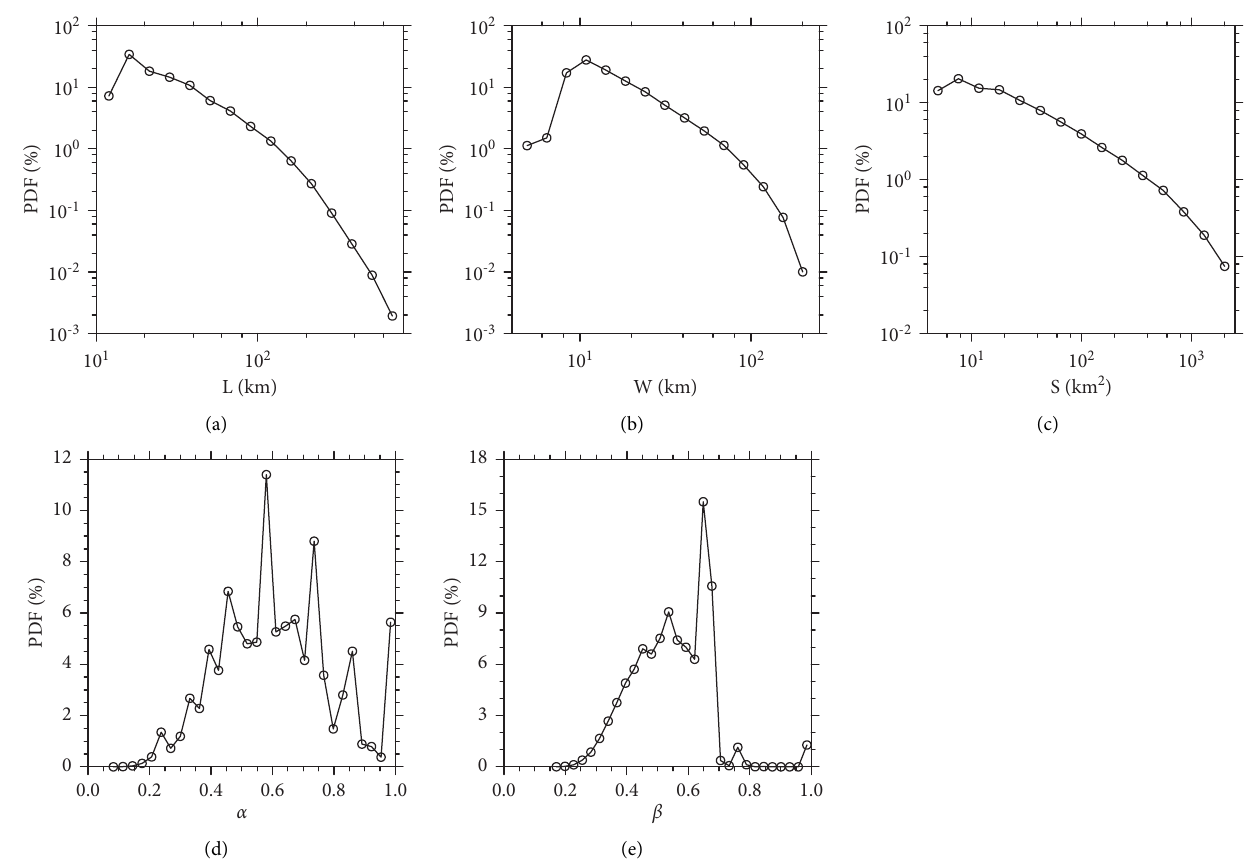
Figure 3: The probability distribution functions (PDFs) of the horizontal geometrical parameters for L (a), W (b), S (c), α (d), and β (e) on Tibetan Plateau calculated from 1998 to 2015. Table 4: The calculated mean geometrical (horizontal and vertical) and physical parameters of precipitation clouds. Geometrical parameters Average Physical parameters Average L (km)